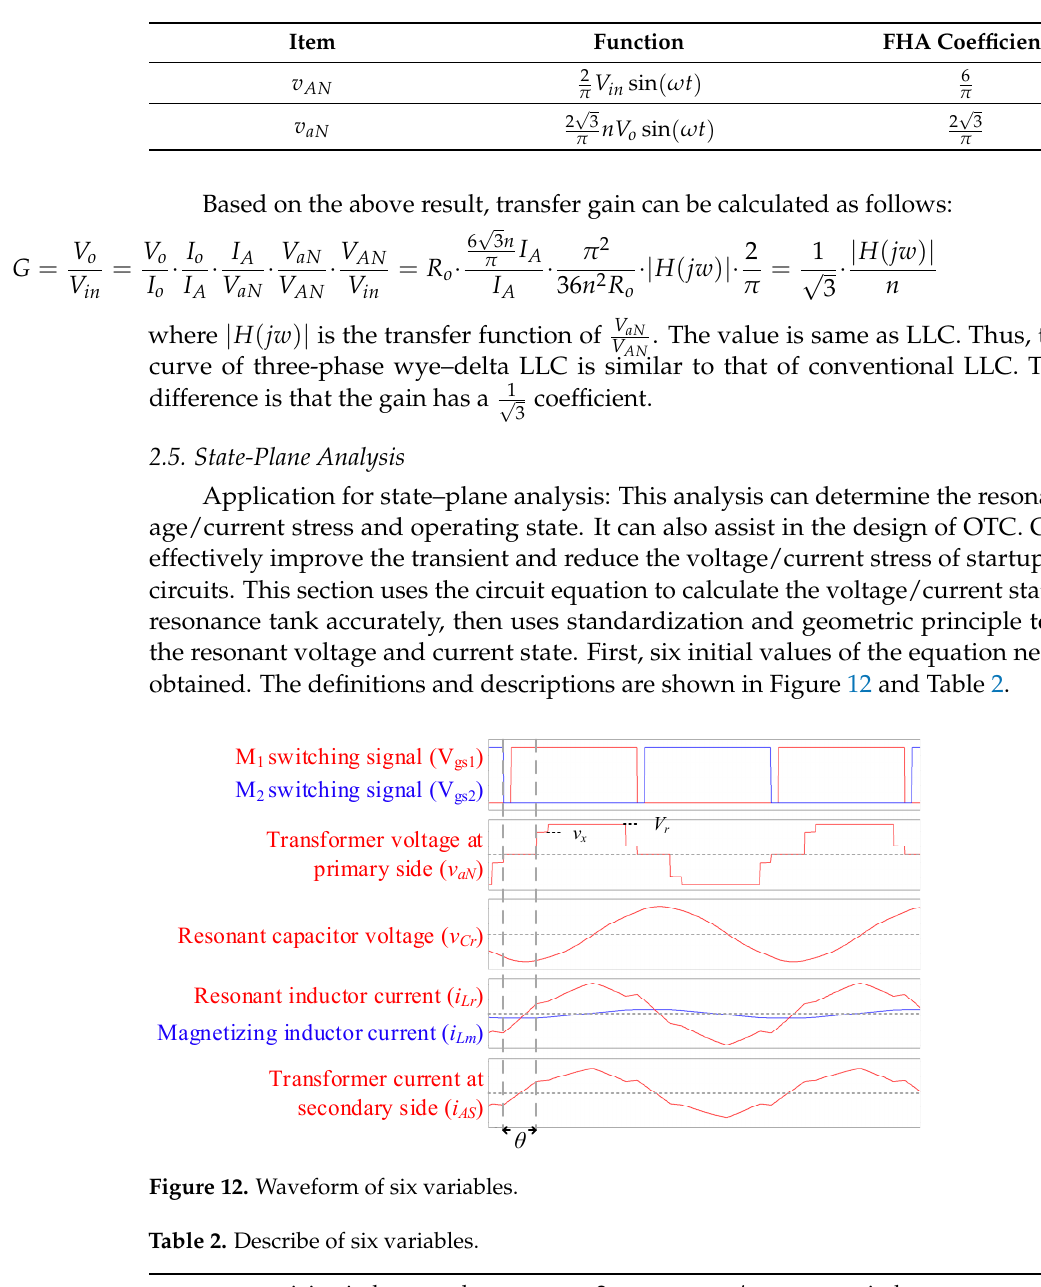
Table 1. Function and FHA coefficient.